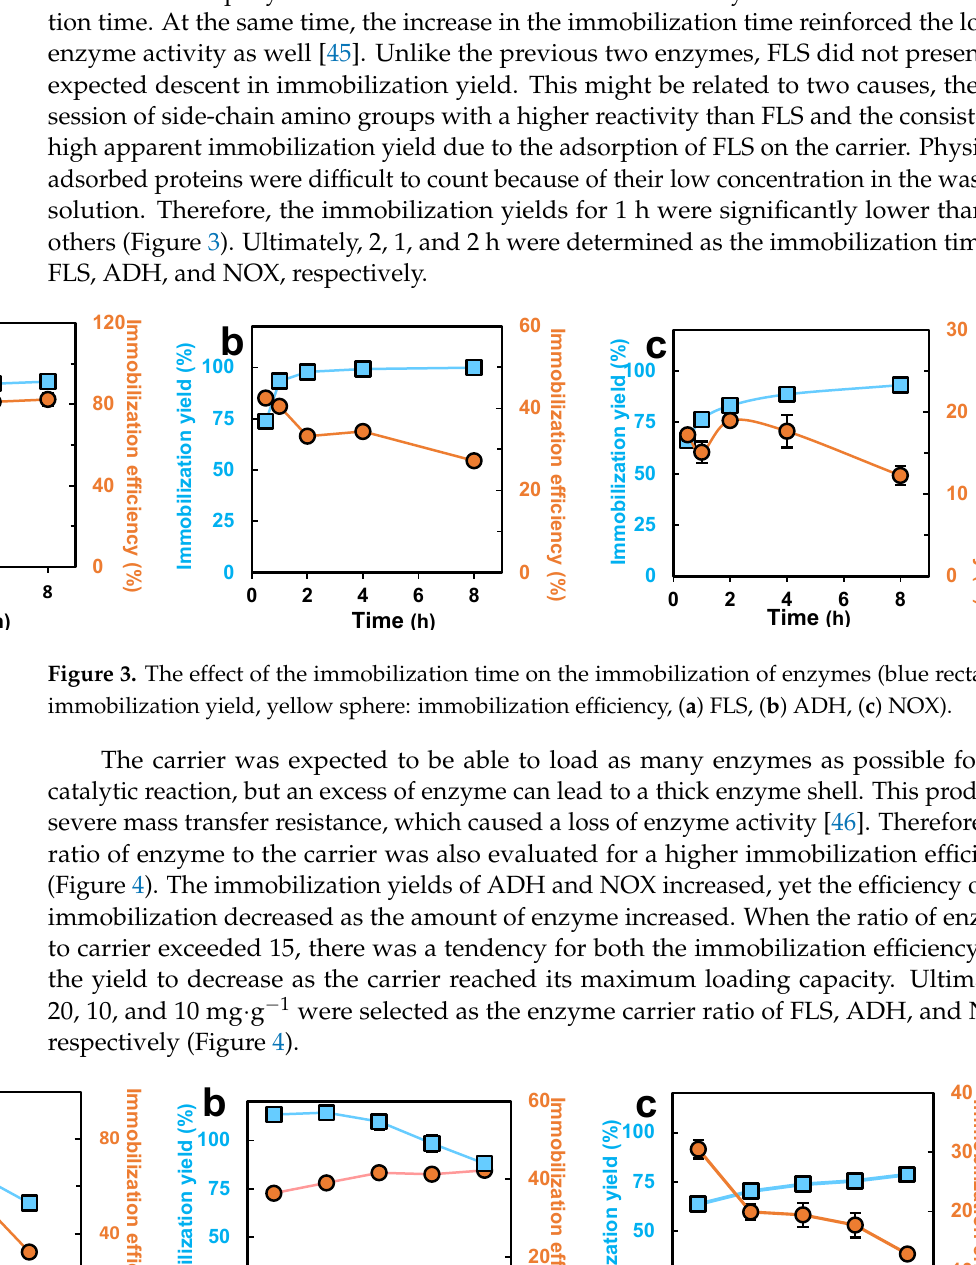
Figure 2. The effect of pH on immobilization (blue rectangle: immobilization yield, yellow sphere: immobilization efficiency, ( a ) FLS, ( b ) ADH, and ( c ) NOX).